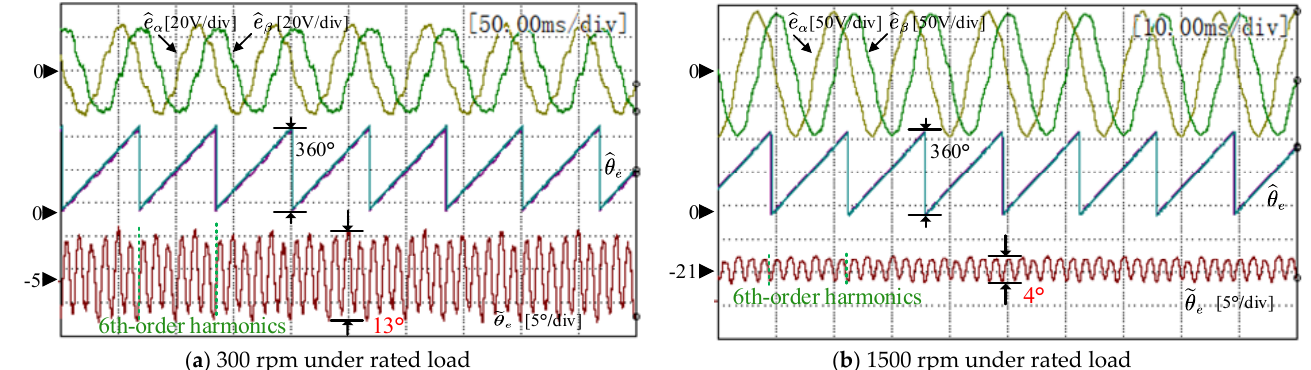
Figure 13. Experimental results of the estimated back-EMF, the estimated position, and the position error under rated load (conventional QPLL).